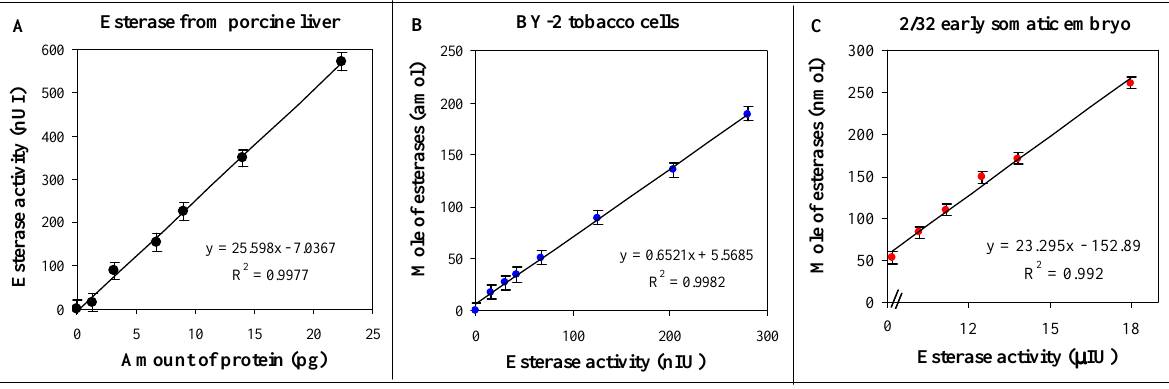
Figure 4. Standardization and calibration of plant esterase detection. Calibration dependence of amount of pig liver esterases on esterase activity ( A ). Dependence of plant esterase activity on mole of esterases contained in BY-2 tobacco cells ( B ) and 2/32 early somatic embryos ( C ). Amount of PE was recalculated according to esterase activity of a known amount of pig liver esterase. The most effective experimental conditions for esterase determination are listed in Fig. 3. For other details, see Results and Discussion